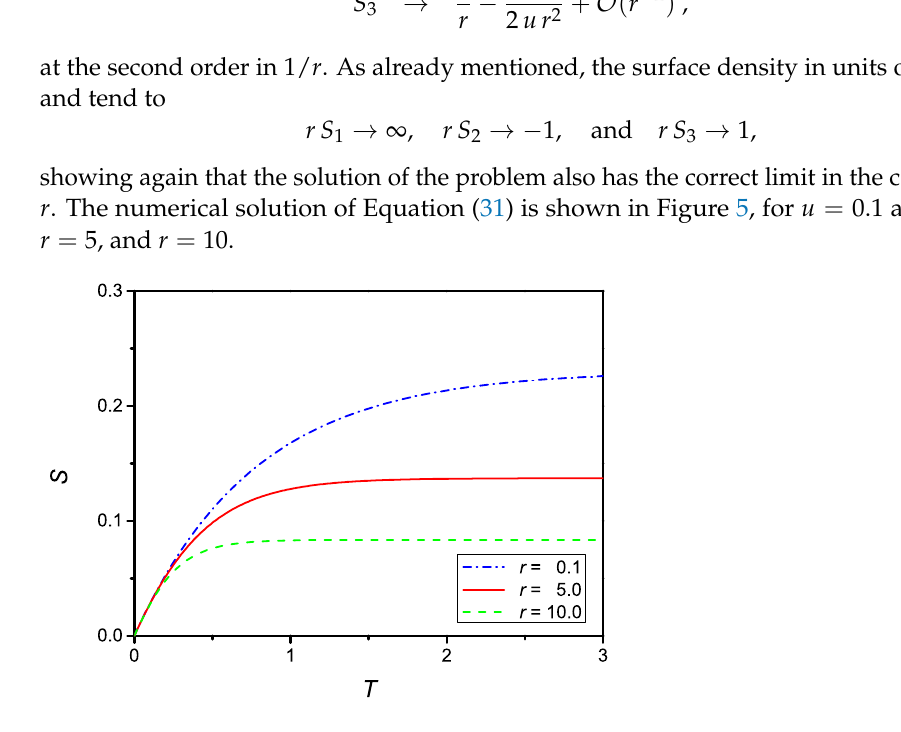
Figure 5. Dependence on the dimensionless surface density of adsorbed particles, S ( T ) , versus the dimensionless time, T , in the case of a quadratic reduction of the adsorption coefficient. The curves were numerically obtained for u = 0.3 and three values of r : r = 0.1 (dash-dotted), r = 5 (full), and r = 10 (dashed).